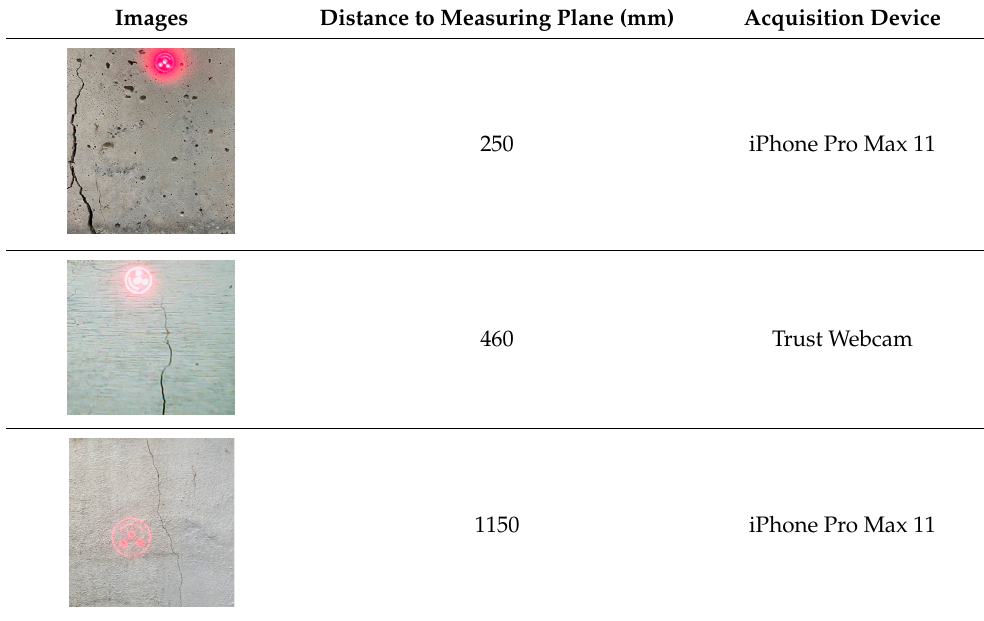
Figure 2. Relationship between distance to measuring plane and laser beam diameter.